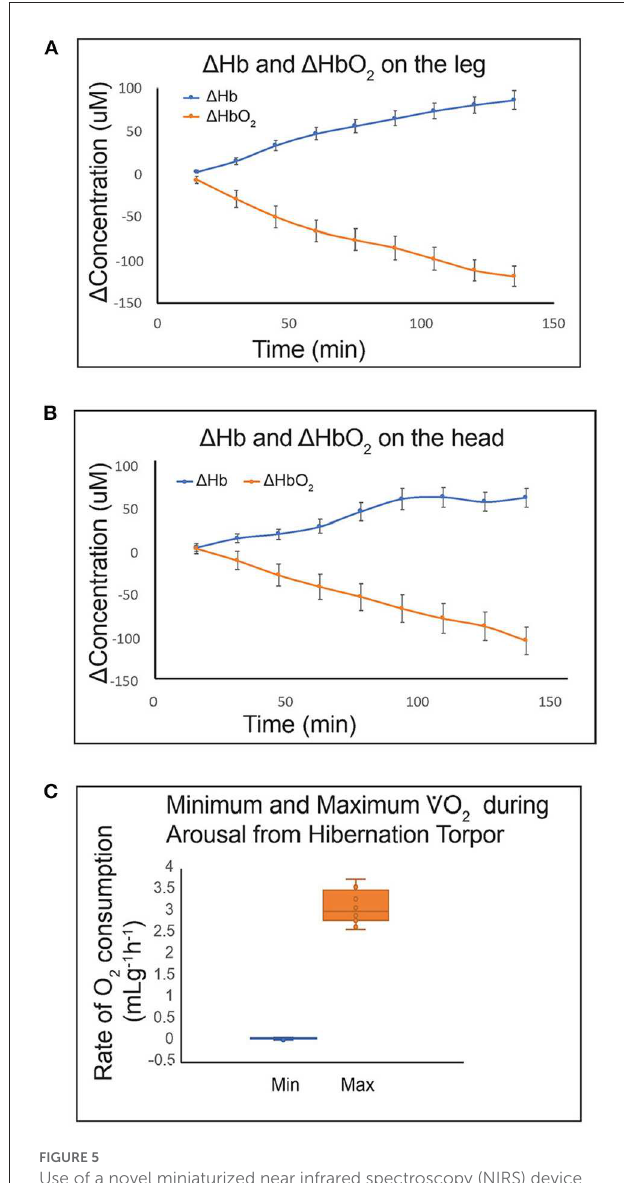
FIGURE5 Use of a novel miniaturized near infrared spectroscopy (NIRS) device for quantifying Hb and HbO 2 in small animals shows that HbO 2 decreases during arousal from hibernation in hind leg (A) and brain (B) tissue. Hibernating AGS fit with sensors on the head and leg were placed in a metabolic cage at 0min. Handling-induced arousal produced tissue hypoxia in both tissues. Rate of O 2 consumption increased from 0.06 mLg − 1 h − 1 at 0min to a maximum of 3.1 mLg − 1 h − 1 between 131 and 231min. Data shown are mean ± SEM